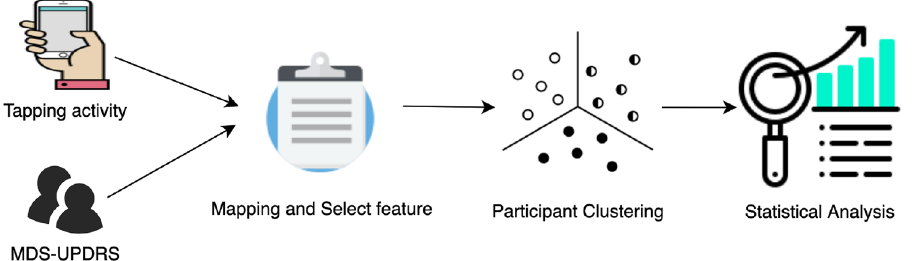
Figure 1. Overview of the process performed in this